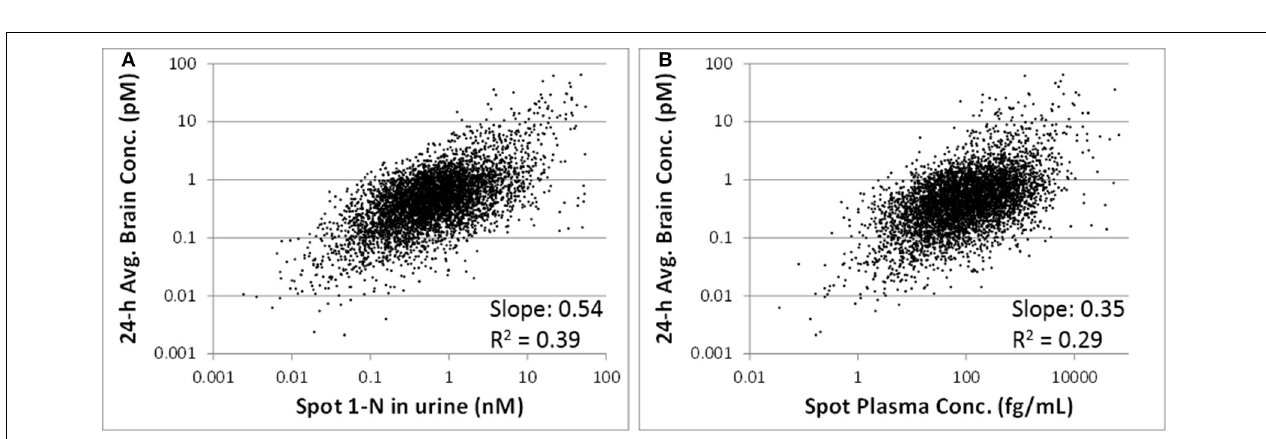
vs. 24-h averaged AChE inhibition in RBC (time averaging was over the 24h prior to urine sampling); (C) Spot percent AChE inhibition in the brain vs. spot 1-N concentrations in urine (nM); (D) Spot percent AChE inhibition in the brain vs. spot carbaryl concentrations in plasma (pM).